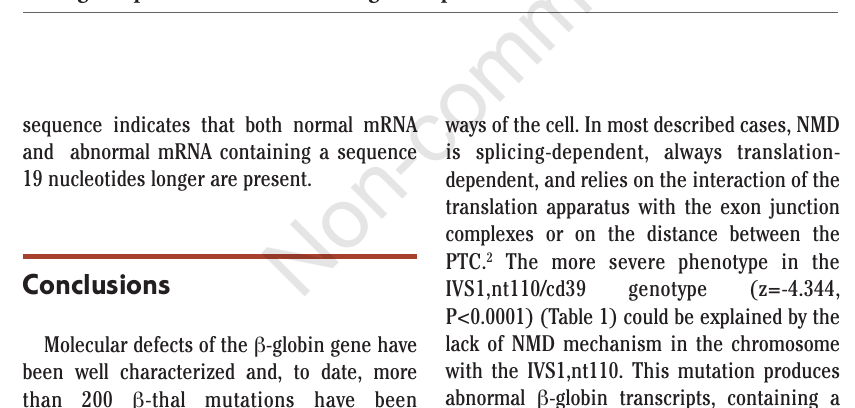
Figure 2. Direct sequencing of β -globin cDNA-polymerase chain reaction products. (A and B) Normal subjects. (C and D) IVS1,nt110 homozygous patients. Interruption of the frame sequence (see arrows) indicates that both normal mRNA and abnormal mRNA con- taining a sequence 19 nucleotides longer, are